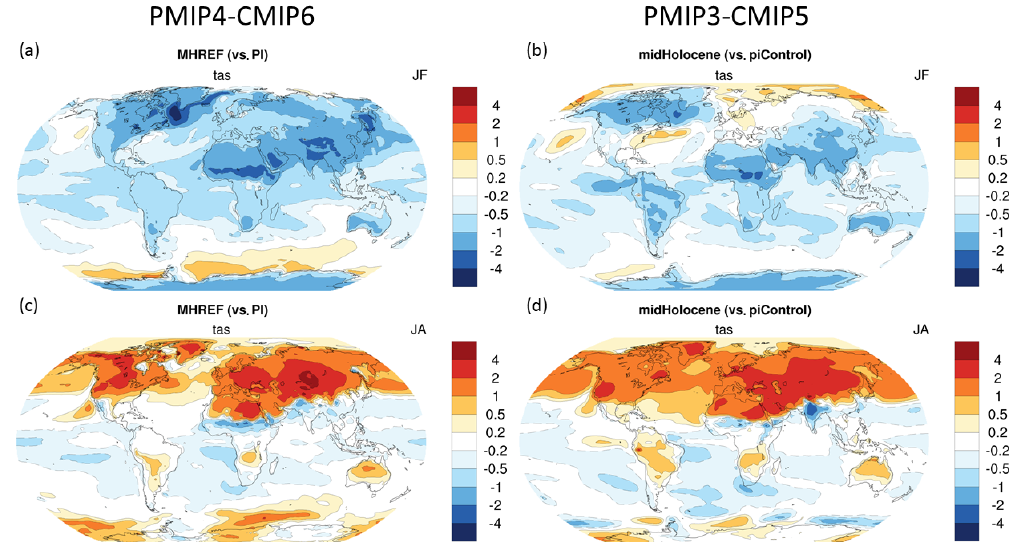
Figure 4. (a, b) 2m air temperature differences (tas, ◦ C) between the mid-Holocene and the pre-industrial climates as simulated for January– February (JF) and (c, d) July–August (JA) in (a, c) the IPSL-CM61-LR PMIP4-CMIP6 simulations and (b, d) the IPSL-CM5A-LR PMIP3- CMIP5 simulations.